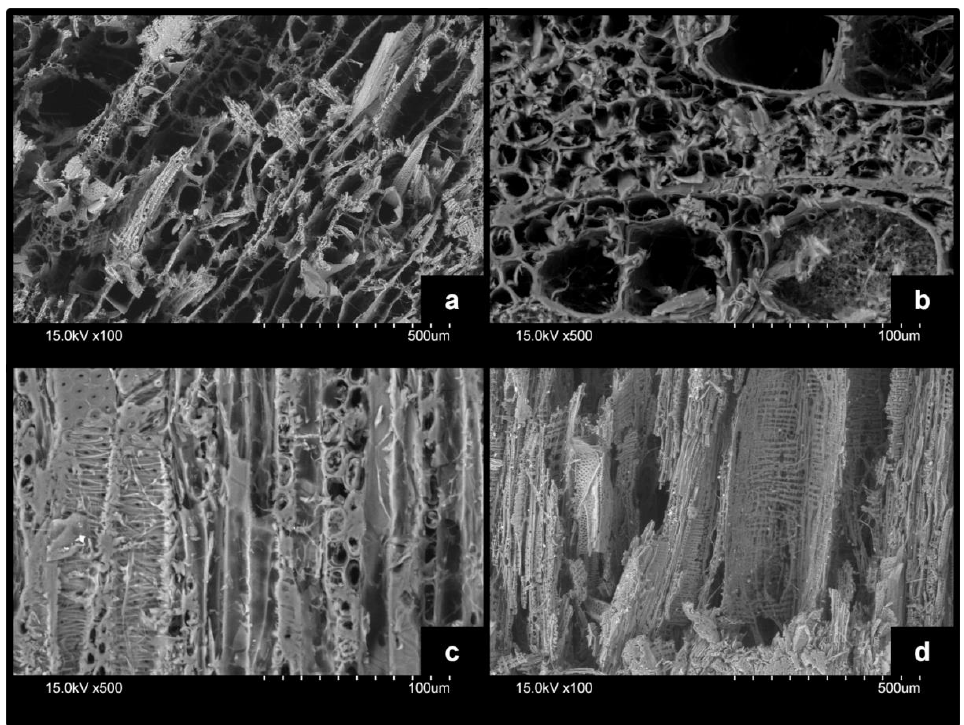
Figure 6. SEM pictures of cross section (above) and longitudinal section (below) of locally decayed hornbeam wood: ( a ) cell wall thinning, ( b ) fungal hyphae in lumen, ( c ) gradual disappearance of bordered pits, ( d ) fibrous tissue.